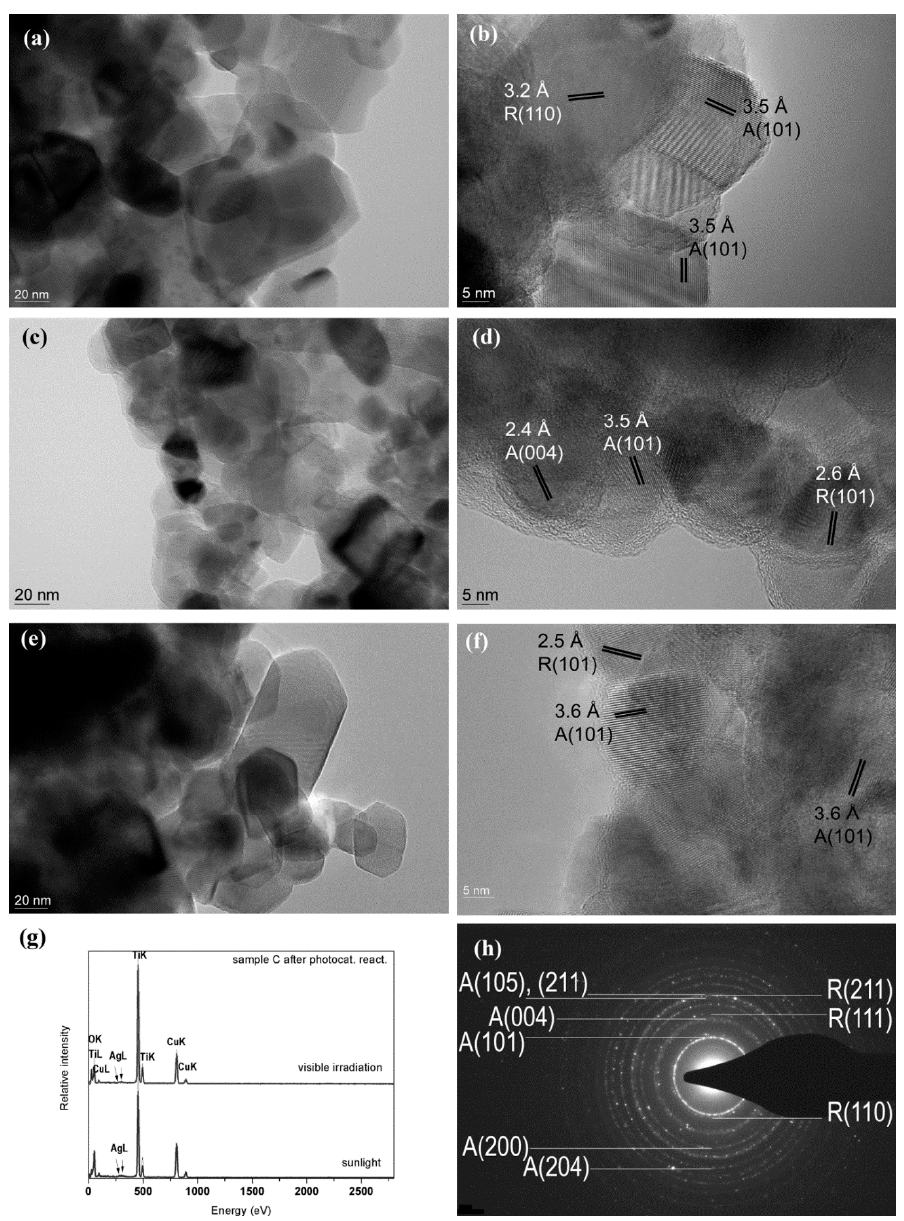
Figure 4. Sample S3: TEM ( a ) and HRTEM ( b ) images before photo ‐ catalytic reaction, TEM ( c ) and HRTEM ( d ) images after photo ‐ catalytic reaction using only visible part of the spectra, TEM ( e ) and HRTEM ( f ) images after photo ‐ catalytic reaction using sun light, EDXS of the sample after photo ‐ catalytic reaction using sun light ( g ), SAED of the sample before photo ‐ catalytic reaction ( h ). The presence of Ag in small amounts is observed in all analyzed samples before and after photocatalytic reaction by EDXS measurements (Figures 3g and 4g). The average atomic percentage of Ag indicated by multiple EDXS measurements in S2 was (0.5 ± 0.1) at %, while S3 contained